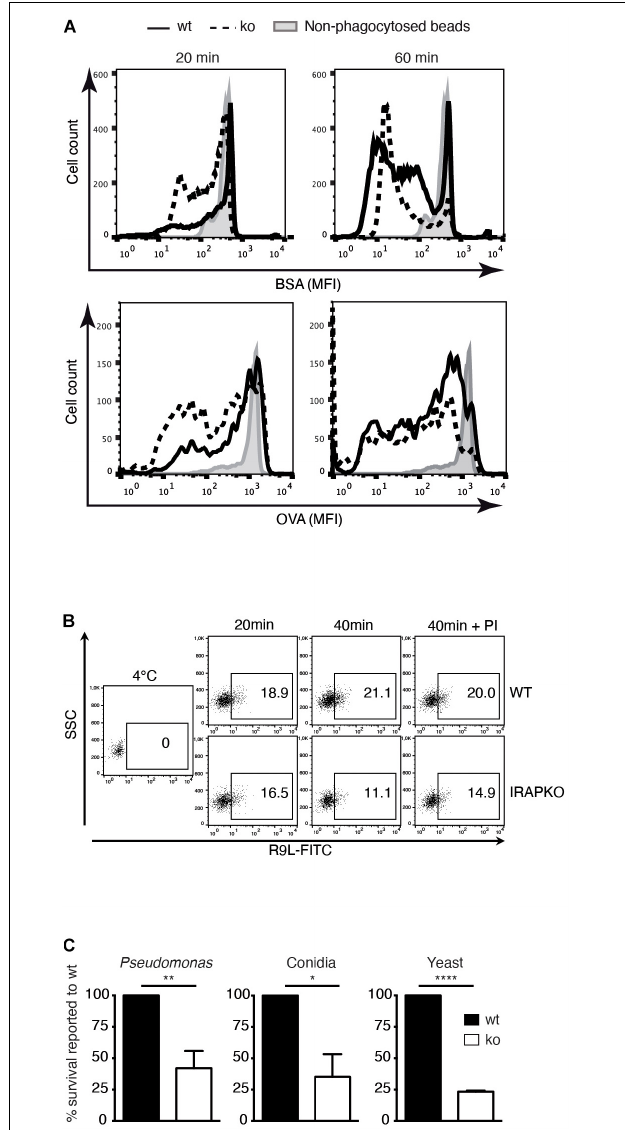
FIGURE 2 | Insulin-regulated aminopeptidase (IRAP) - / - phagosomes are more degradative and microbicidal. (A) Wild-type (wt) and IRAP - / - bone marrow-derived dendritic cells (BM-DCs) were pulsed for 20 min with latex beads coupled to ovalbumin (OVA) or bovine serum albumin (BSA) and half of the cells were chased for 40 min. The cells were lysed, and the beads were stained for BSA or OVA and analyzed by flow cytometry. One out of three or more experiments. (B) BM-DCs were incubated for 20 min with latex beads, washed, and lysed mechanically immediately or after another 20 min incubation at 37 ◦ C for phagosome preparation. The phagosomes obtained from wt and IRAP - / - BM-DCs were incubated for 15 min at 4 ◦ C or 20 ◦ C with peptide R9L-FITC followed by analysis of peptide accumulation by fluorescence-activated cell sorting (FACS). One representative of